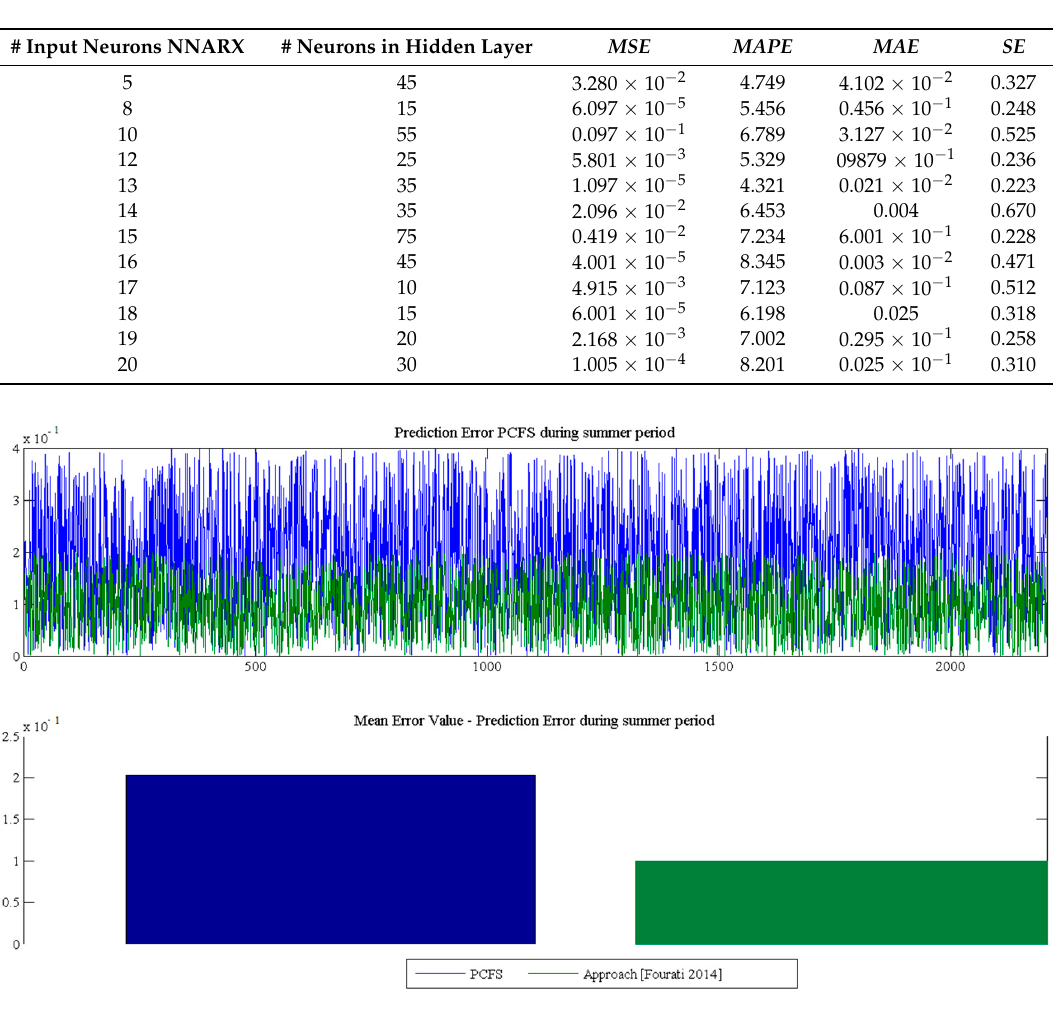
Table 3. ANN performance indices-the chosen number of neurons is the one in the row with a grey background. NNARX: auto-regressive neural network with external inputs. # Input Neurons NNARX